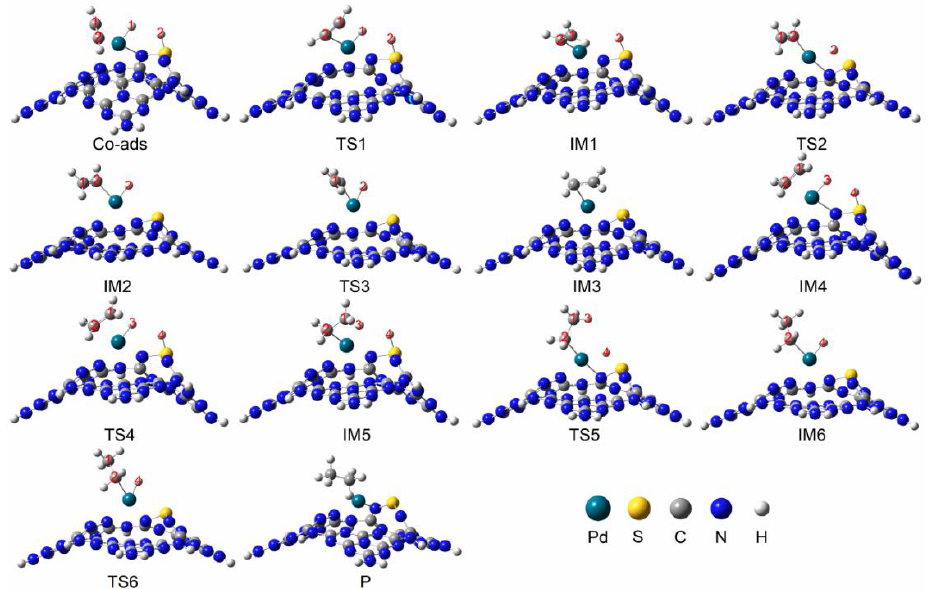
Figure 4. The reaction mechanism of acetylene hydrogenation catalyzed by S-doped C site and their corresponding structures.